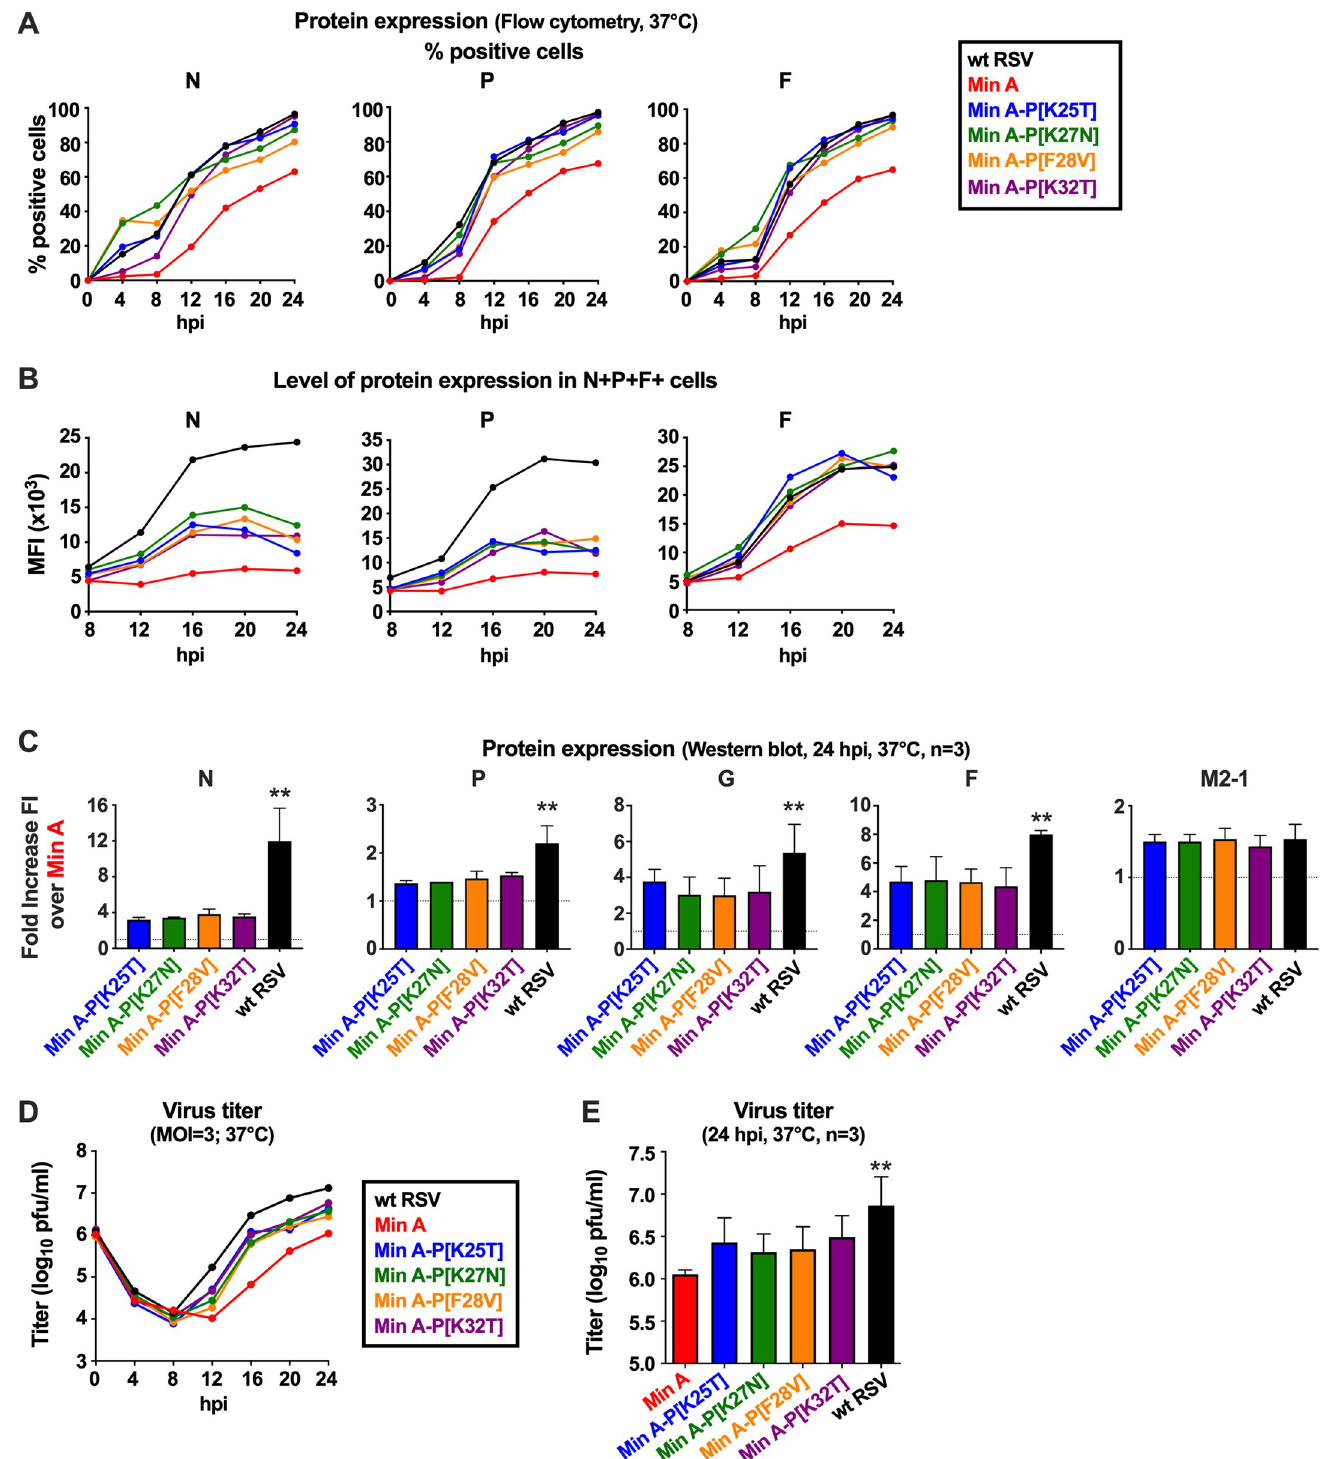
Fig 4. The P mutations increased Min A protein expression and virion production during a single-cycle infection. (A, B, C) Protein expression . (A, B) Additional replicate Vero cell monolayers in six-well dishes from the single-cycle infection experiment in Fig 3 (MOI of three PFU/cell, 37˚C) were harvested at four-h intervals from four to 24 hpi (one well per virus per time point) for analysis of protein expression by flow cytometry (A, B). (A, B) Cells were harvested, fixed, permeabilized, immunostained, and subjected to flow cytometry to determine the percentage of cells that expressed N, P, and F proteins (A) as well as the median fluorescence intensity (MFI) of the positive cells (B). (C) Western blotting from additional replicate Vero cell monolayers in six-well dishes from the single-cycle